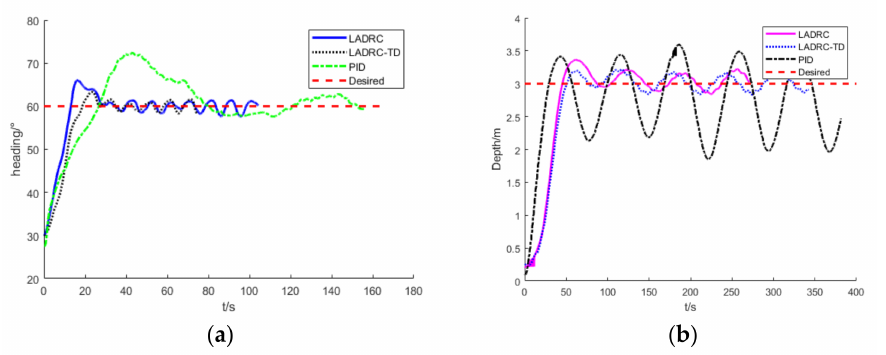
Figure 11. Fixed-point experiment; ( a ) step response in heading control; ( b ) step response in the depth